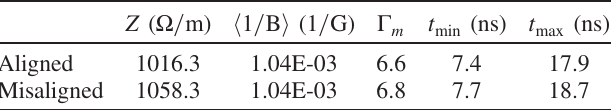
, and the minimum and m are also m